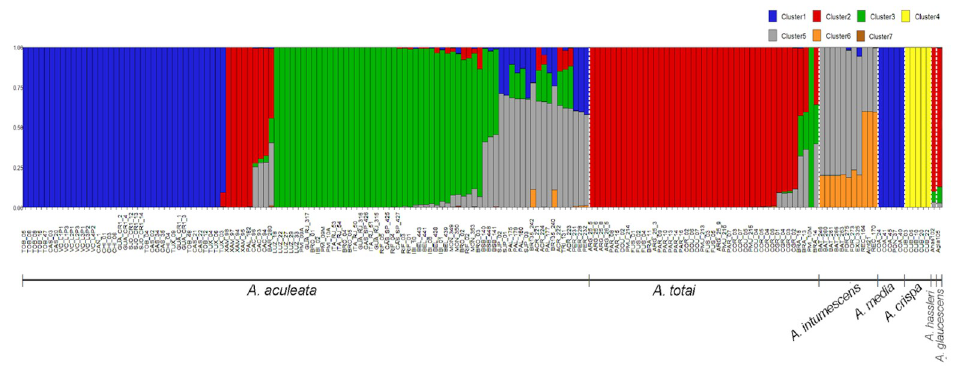
Fig 2. Genomic structure of 172 samples from Acrocomia species based on 3227 neutral SNP loci. The y-axis is the population membership, and the x-axis is the sample. Each vertical bar represents a sample and color represent separate clusters ( K =